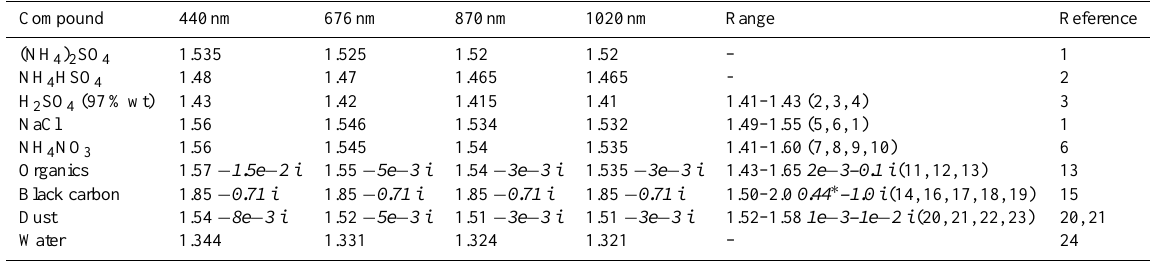
Table 4. Refractive indices for four different wavelengths (440, 676, 870 and 1020nm) presented with a range found in the literature. When no imaginary part ( italic ) is listed, it is assumed to be zero. Compound